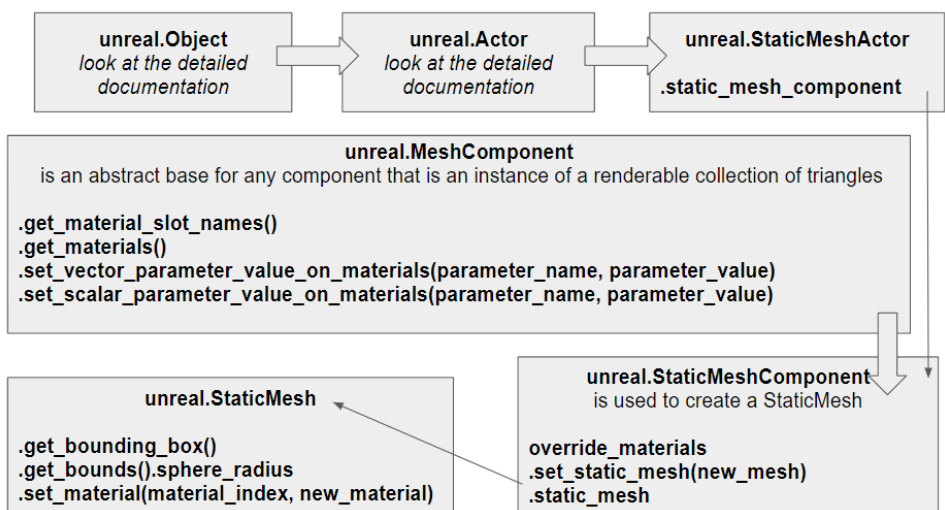
Figure 14. Unreal documentation: some Unreal classes that are useful to know when performing material and mesh replacement.